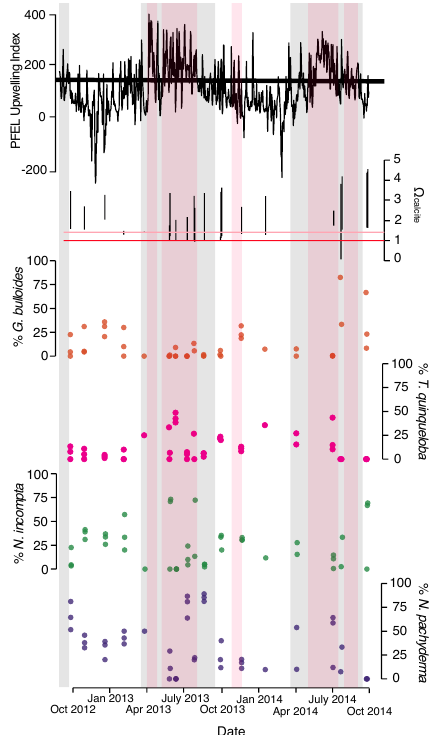
Figure 4. Upwelling index for 39 ◦ N (PFEL; http://www.pfeg.noaa. gov/products/PFEL/modeled/indices/upwelling/upwelling.html),), with “upwelling season” shaded in grey and periods of sustained upwelling conditions during the relevant years shaded in red. The range of C alcite observed on each tow is marked in black, with (cid:127) calcite = 1 marked in red and (cid:127) calcite = 1.5 in pink. Percent abundances from vertical tows of G. bulloides, T. quinqueloba , N. incompta , and N. pachyderma from offshore stations BL3, BL4, BL5, and off-shelf stations AW2, AW4, and AW6 shown in orange, pink, green, and purple,